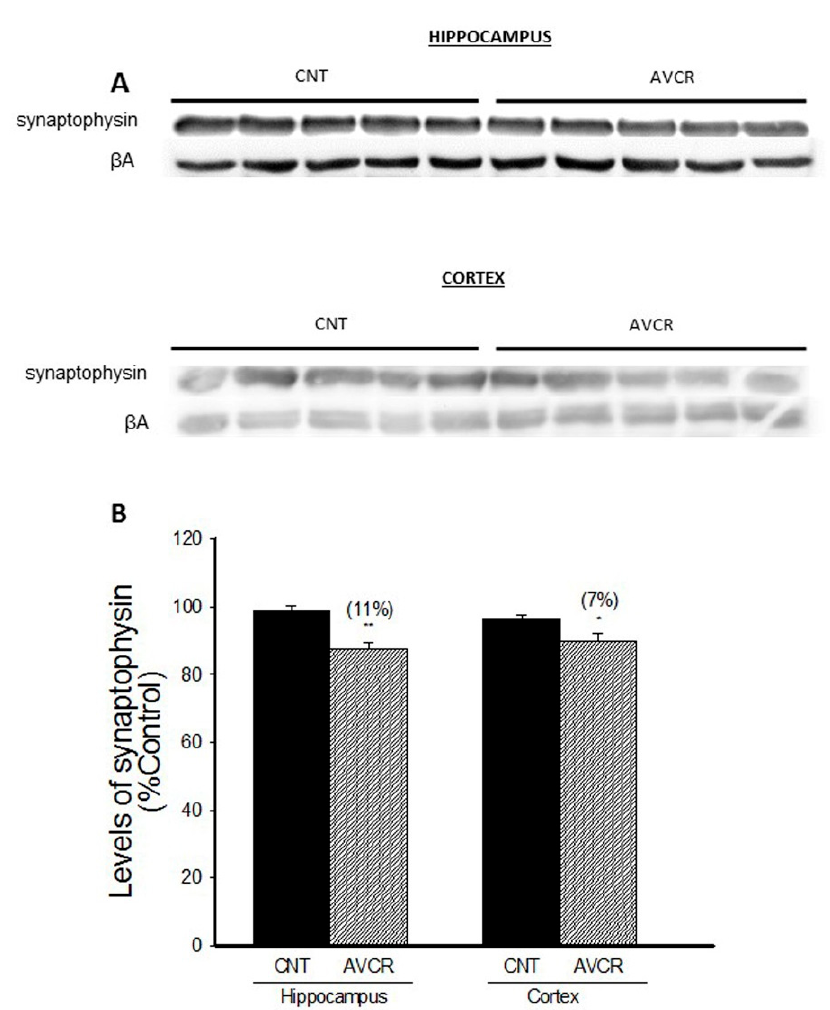
Figure 5. Effect of AVCRI104P3 on synaptophysin in the hippocampus and cortex of 12-month-old 129/Sv × C57BL/6 male mice. ( A ) Representative Western blot images of synaptophysin. β -actin were used as internal control. ( B ) Photodensitometric quantification of WB experiments was used to evaluate changes in synaptophysin expression. The results are the mean ± SEM of 3–4 experiments (5 mice/treatment group). The statistical analysis used was one-way ANOVA followed by Dunnett’s test, * p < 0.05, ** p < 0.01 vs.